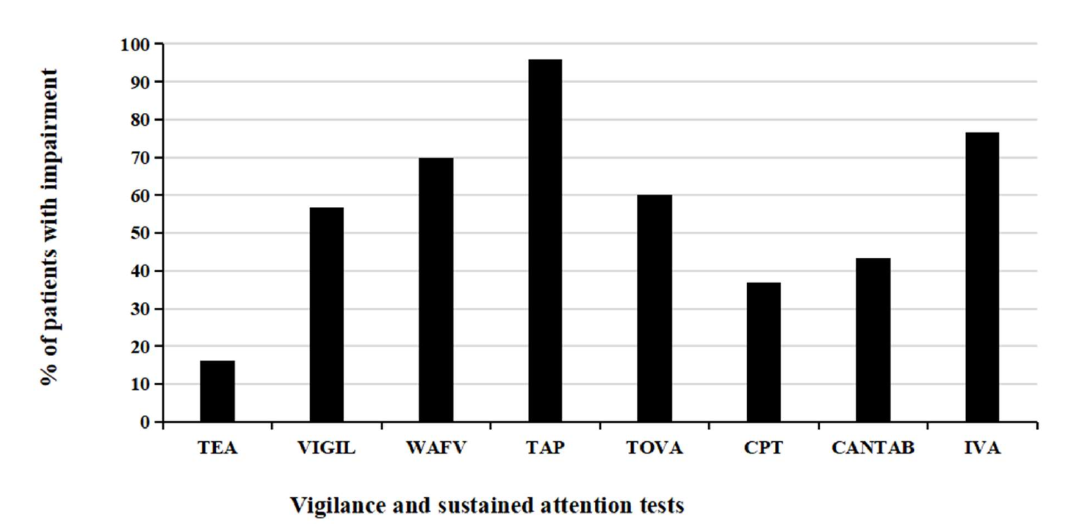
Figure 3. Proportion of patients with ADHD showing impairment in the various tests. Note: A test is defined as impaired if at least one test variable showing impairment. A test variable is defined as impaired when T -score ≤ 40. TEA = Test of Everyday Attention. VIGIL = VIGIL of the Vienna Test System (VTS). WAFV = Perception and Attention Functions—Vigilance of the VTS. TAP = Test Battery for Attention Performance. TOVA = Test Of Variables of Attention. CPT = Conners’ Continuous Performance Test. CANTAB = Cambridge Neuropsychological Test Automated Battery—Rapid Visual Processing. IVA-2 = Integrated Visual and Auditory Continuous Performance Test.